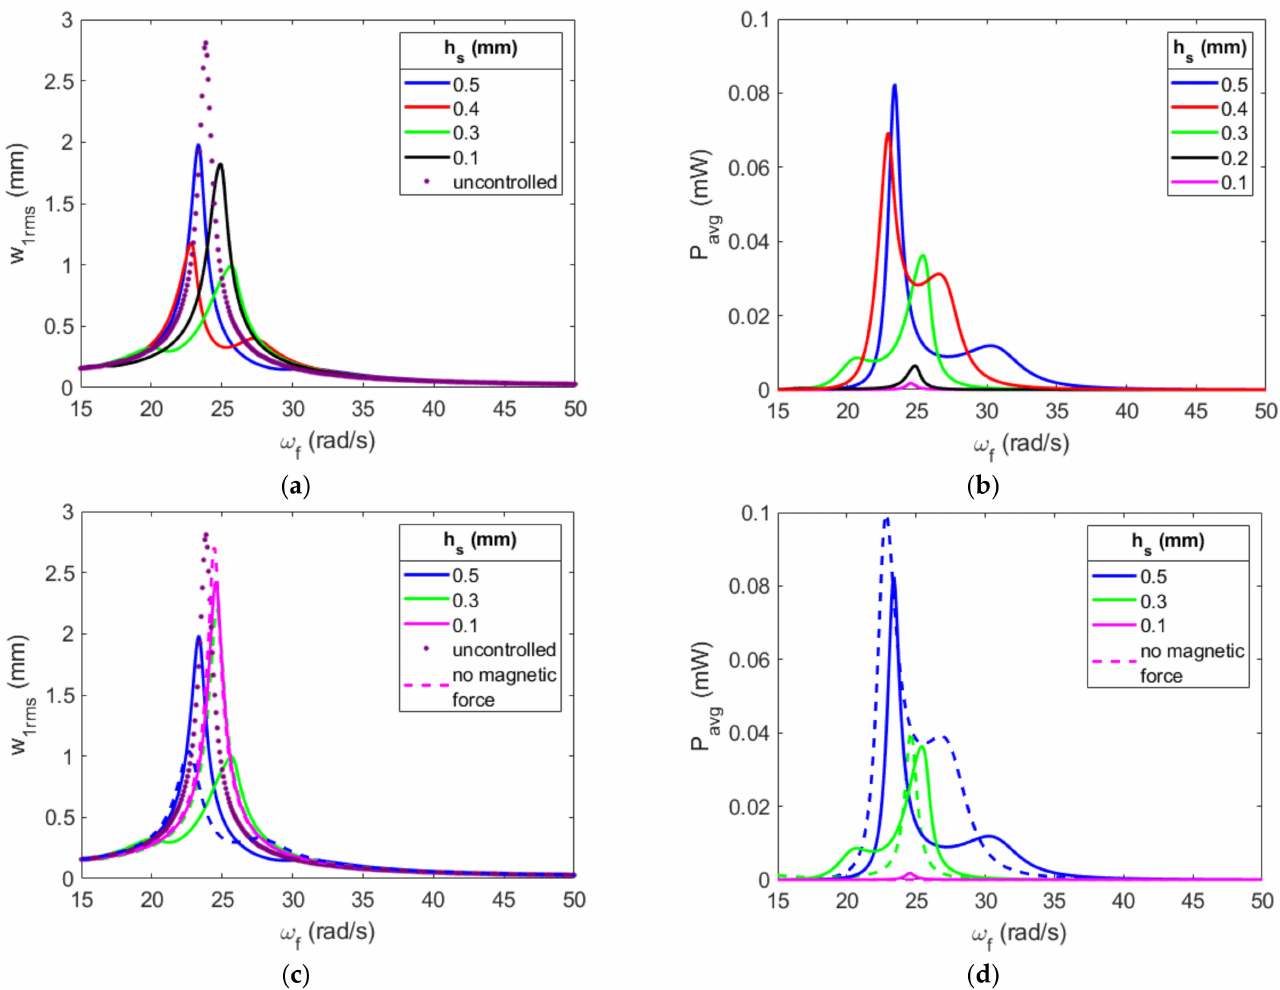
Figure A2. The effects of varying substrate thicknesses with a tip mass of 0.04 kg and an initial gap of 10 mm on the amplitude of the ( a ) primary structure and ( b ) absorber, as well as a comparison with configurations with no magnets ( c , d